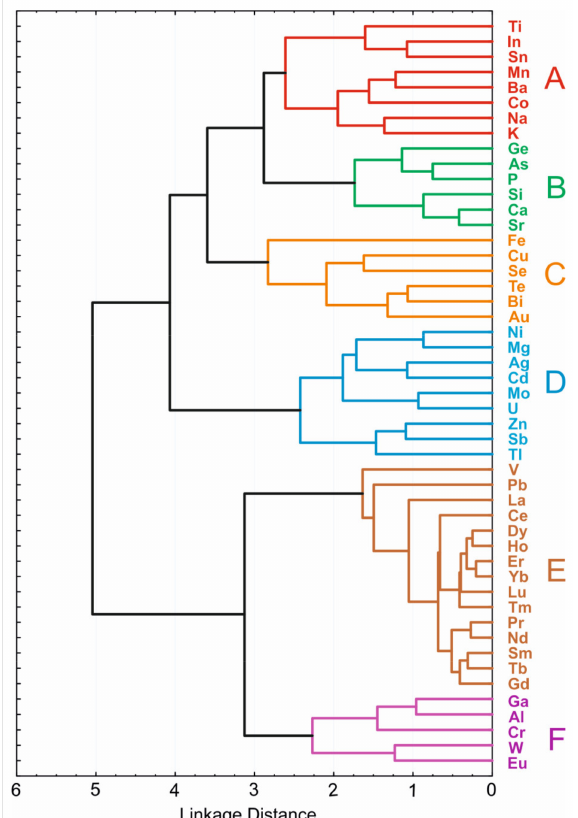
Figure 3. Tree diagram for 49 elements generated by cluster analysis. Complete linkage. Euclidian distance. All IOHs, Pobeda-1 hydrothermal field. TEAs related to: A—a Mn crust; B—an opal– aragonite mineral assemblage with phosphates and arsenates; C—Cu sulfides; D—Zn sulfides interacted with seawater; E—strong linkage of the REEs with Pb and V; F—elements in trivalent form absorbed on the IOHs from clays or